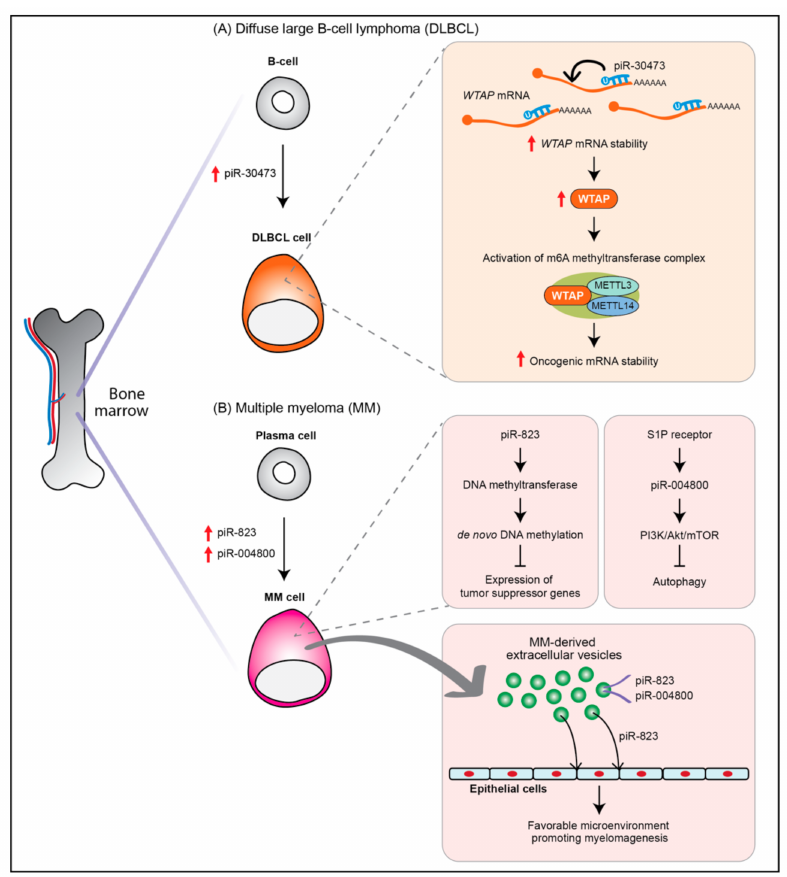
Figure 3. Oncogenic piRNAs in blood cancer. ( A ) piR-30473 promotes the progression of diffuse large B-cell lymphoma (DLBCL) by regulating N6-methyladenosine (m6A) posttranscriptional RNA modification [51,52]. ( B ) piR-823 and piR-004800 promote the progression of multiple myeloma (MM) and are found in MM-derived extracellular vesicles [24,53,54]. The encapsulated piR-823 is released to endothelial cells and leads to establish a favorable microenvironment that ultimately promotes myelomagenesis